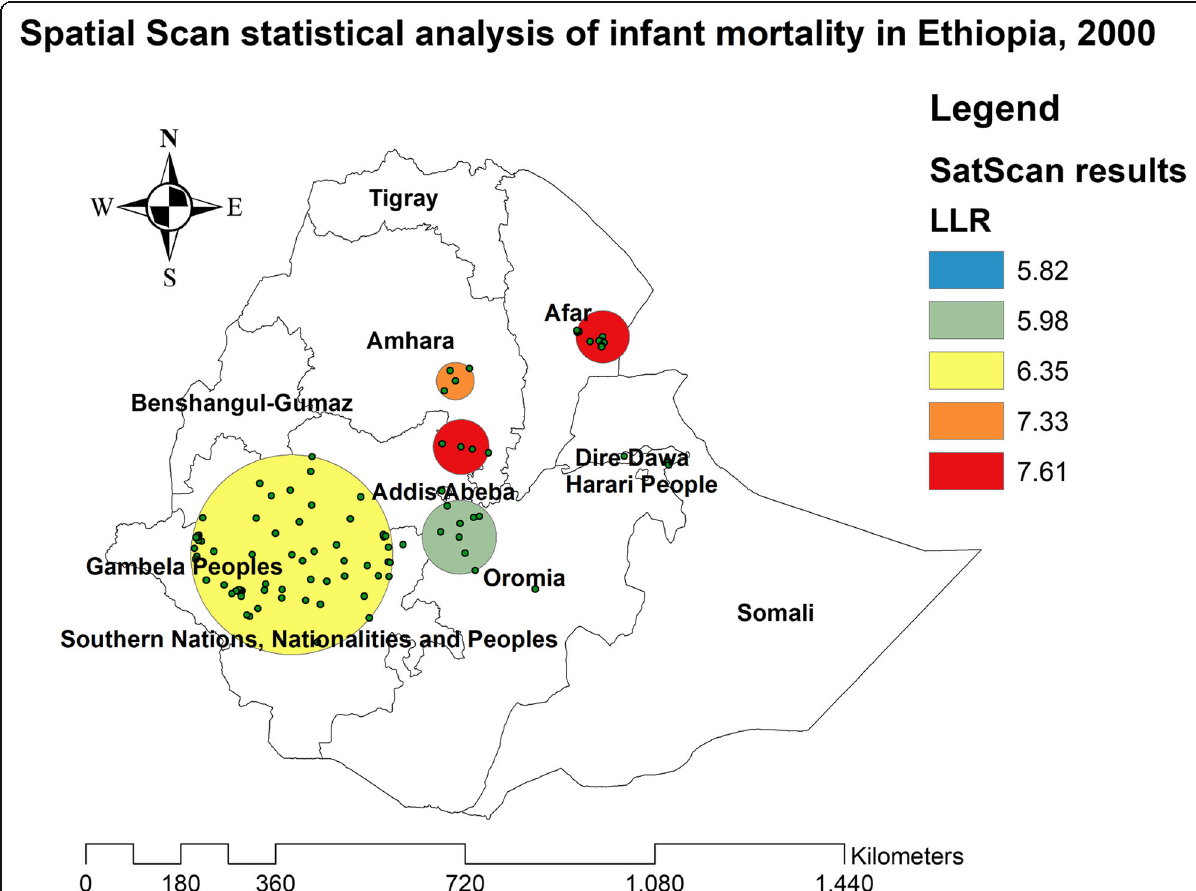
Fig. 2 The SaTScan analysis of infant mortality in Ethiopia in 2000